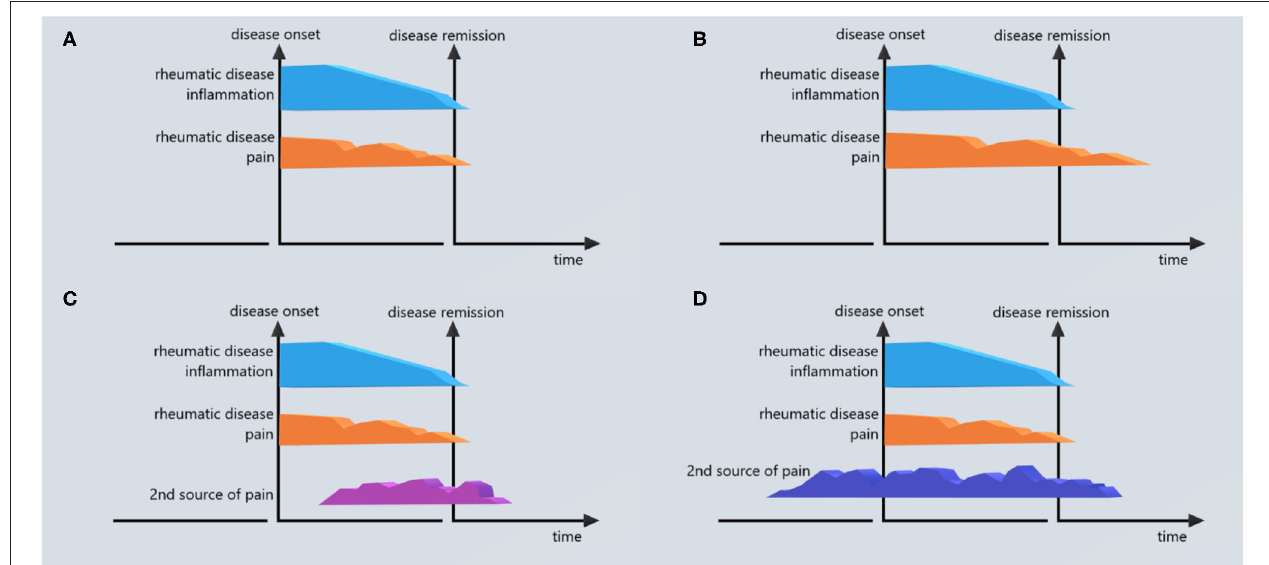
FIGURE 2 | Different scenarios of RP in IRDs. (A) No RP (pain after remission < 20mm VAS). (B) RP is the unresolved part of the pain generated by inflammatory rheumatic disease (IRD). (C) RP comes from a second source developed during the evolution of the rheumatic disease and independent of the pain generated by IRD. (D) RP comes from a second source with the onset that preceded the onset of IRD; this source does not end after the remission of